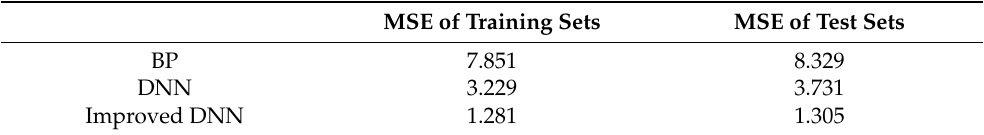
Table 4. Comparison of the